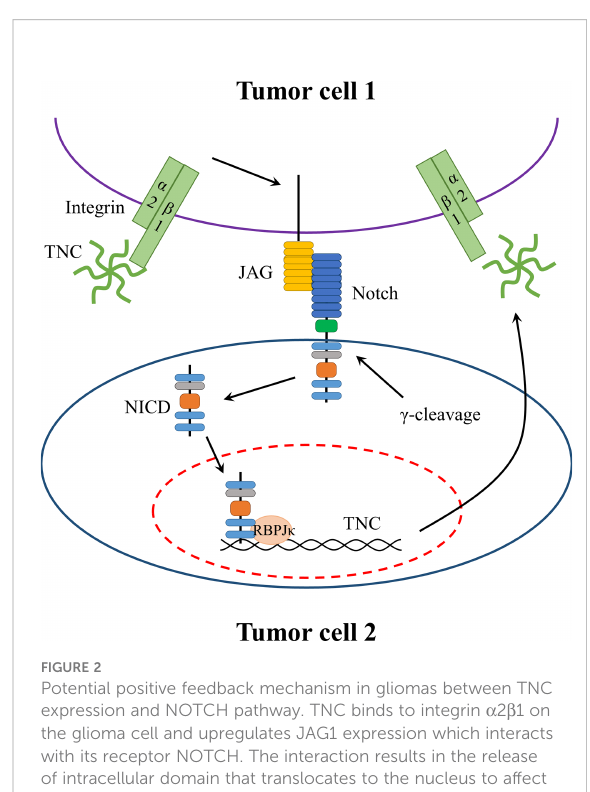
FIGURE 2 Potential positive feedback mechanism in gliomas between TNC expression and NOTCH pathway. TNC binds to integrin a 2 b 1 on the glioma cell and upregulates JAG1 expression which interacts with its receptor NOTCH. The interaction results in the release of intracellular domain that translocates to the nucleus to affect NOTCH-dependent transcriptionby binding to RBPJ k . Moreover, the human TNC promoter containsan RBPJ k -responsive element. Thus, the activationof NOTCHsignaling increases TNC